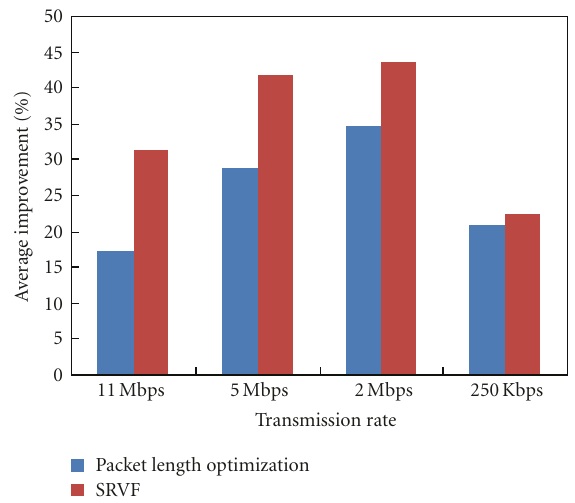
Figure 5: Average theoretical improvement in energy consumption over Simple